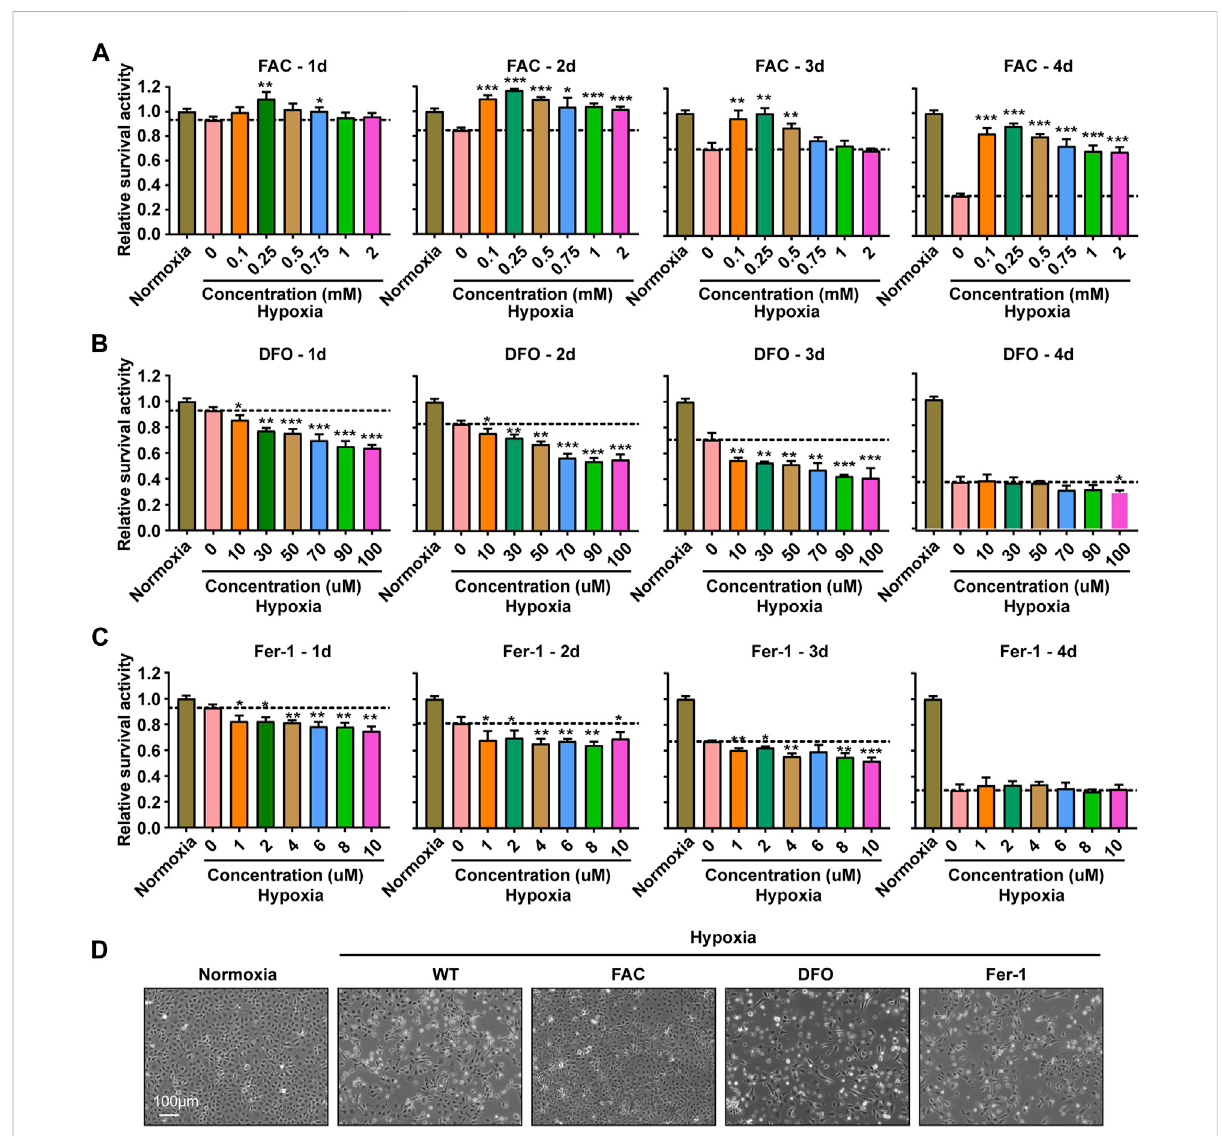
FIGURE 2 Iron supplementation could improve the survival activity of ZFL cells under hypoxia stress, but iron chelation and inhibition of ferroptosis could not. (A – C) Survival rate of ZFL cells analyzed with PrestoBlue ™ HS Cell Viability Regent after treated with a series of concentrations of FAC (A) , DFO (B) and Fer-1 (C) under hypoxic stress from one to 4 days. Hypoxia 0 mM or hypoxia 0 µM was used as a control group for signi fi cance analysis. (D) The microscope analysis of morphology changes of ZFL cells under normoxia or treated with FAC (2.5 mM), DFO (10 µM) and Fer-1 (2.5